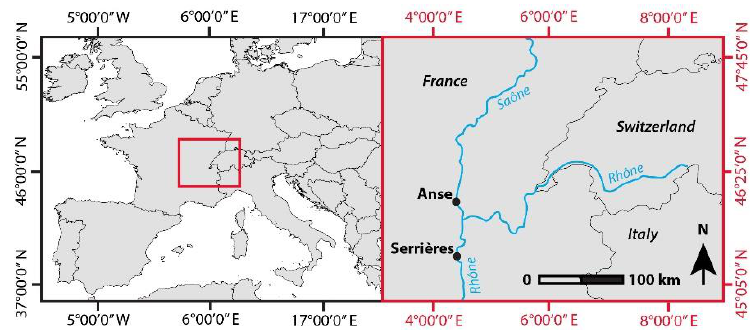
Figure 1. Locations of the study sites.